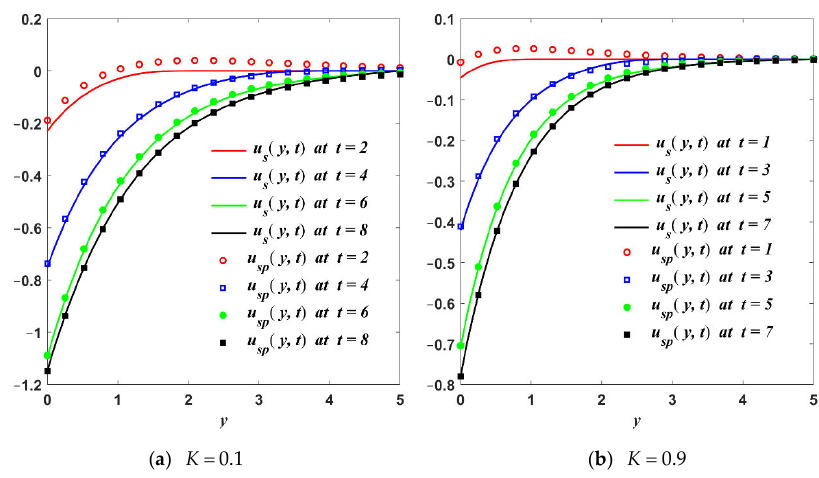
respectively. The intermediate values between the maximum and minimum are denoted by the gradient of the colors between yellow and blue. Figure 8. Convergence of starting velocity u s ( y , t ) (numerical solution) to its steady-state component u sp ( y , t ) for α = 0.8, β = 0.7, γ = 0.6, ω = π /12, M = 0.6, and two values of K . For comparison, as well as to bring to light some characteristic features of the two motions, the spatial distributions of the dimensionless starting velocity fields ),( tyu c and ),( tyu s (numerical solutions) are presented together in Figure 9a,b, respectively, for the same values of the physical parameters. The oscillatory behavior of the two motions, as well as the phase difference between them, can be easily observed. In addition, the initial and boundary conditions were clearly satisfied. Blue and yellow colors were used in the current figure to designate the minimum and maximum values of the two solutions,